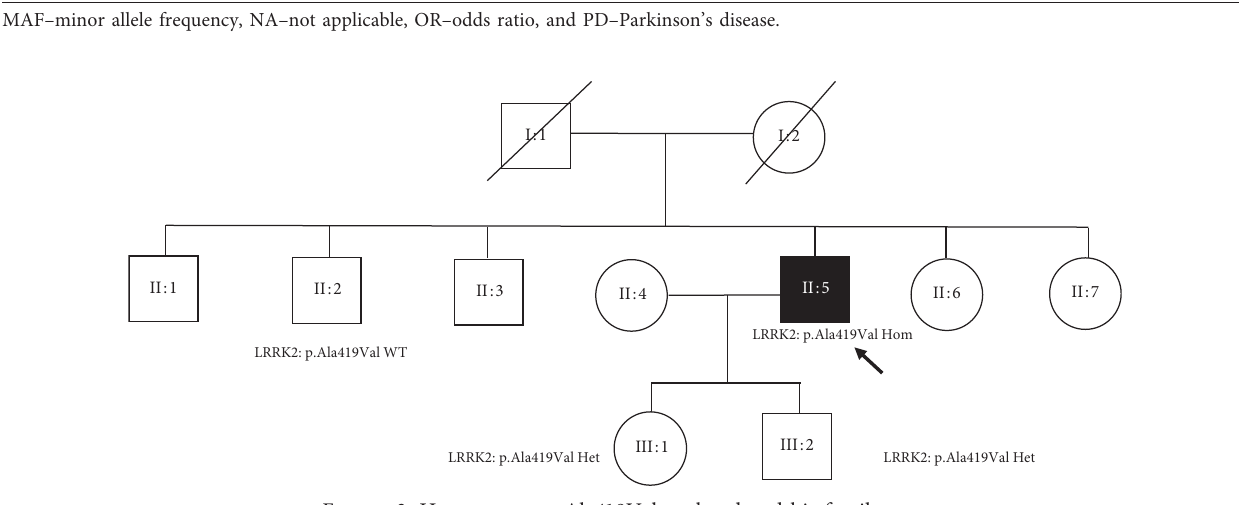
Figure 3: Homozygous p.Ala419Val proband and his family tree. Table 5: p.Ala419Val-positive PD patients and their